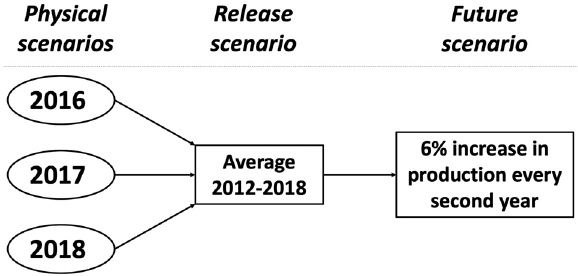
Fig. 3. Modeling approach. Three different physical scenar- ios were used (2016−2018) together with a simulated lice release based on the average from 2012 to 2018. The future scenario included a biennial increase of 6% in salmon production from the average level in